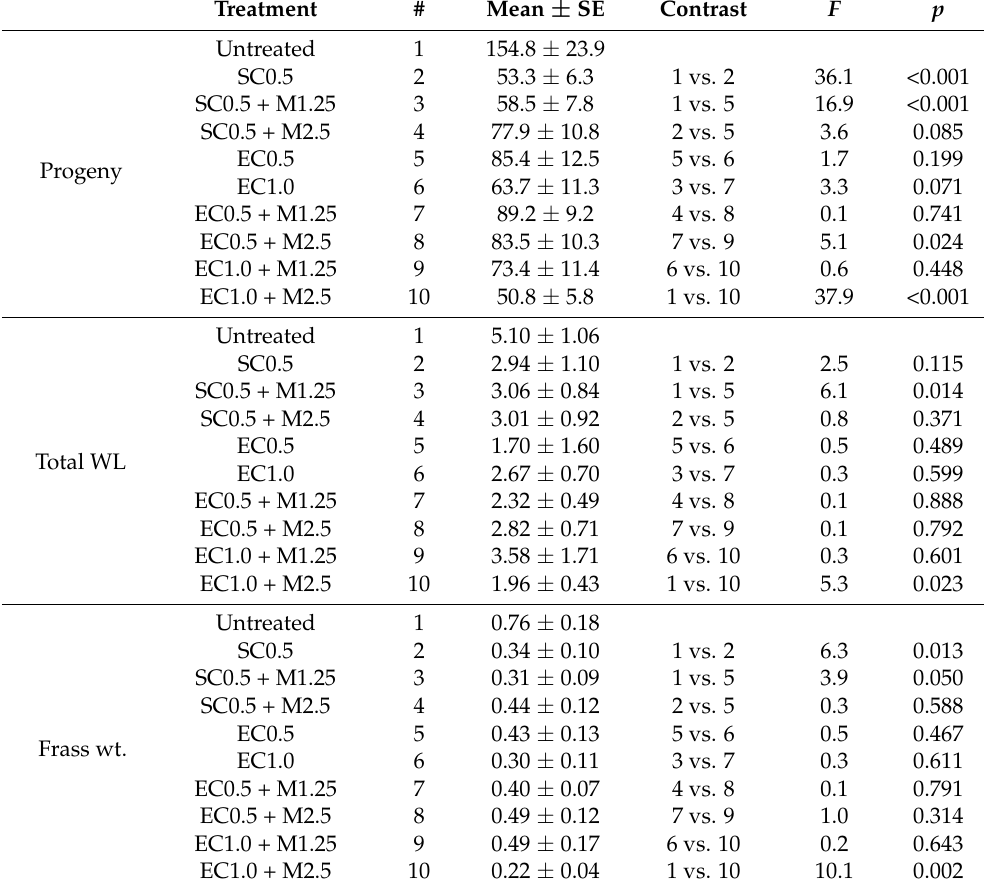
Table 3. Progeny production, total weight loss (WL in %), and feeding damage (Frass wt. in g) (means ± SE) from exposure of 10 mixed-sex parental adult S. oryzae on untreated brown rice and brown rice treated with the insecticide combinations Table 1. F and p values given for selected orthogonal